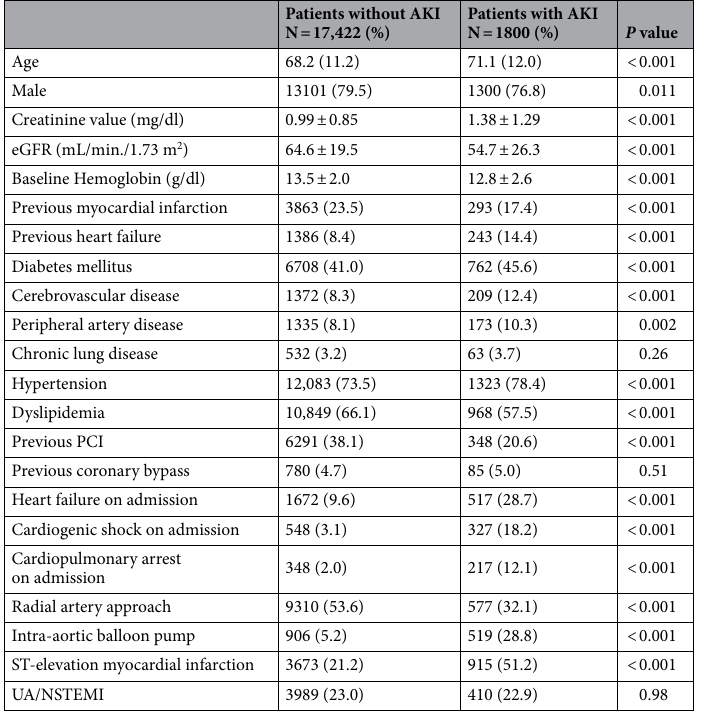
Table 1. Baseline characteristics of all patients. ±: SD, AKI: acute kidney injury, eGFR: estimated glomerular filtration rate, PCI: percutaneous coronary intervention UA/NSTEMI: unstable angina/non ST-elevation myocardial